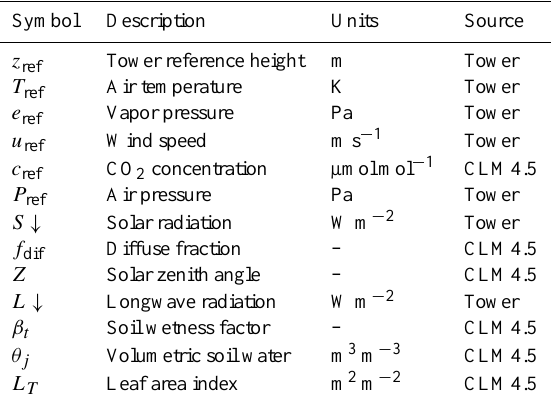
Table 4. Site-specific model input. The model additionally uses the canopy height, plant functional type, and soil texture at each tower